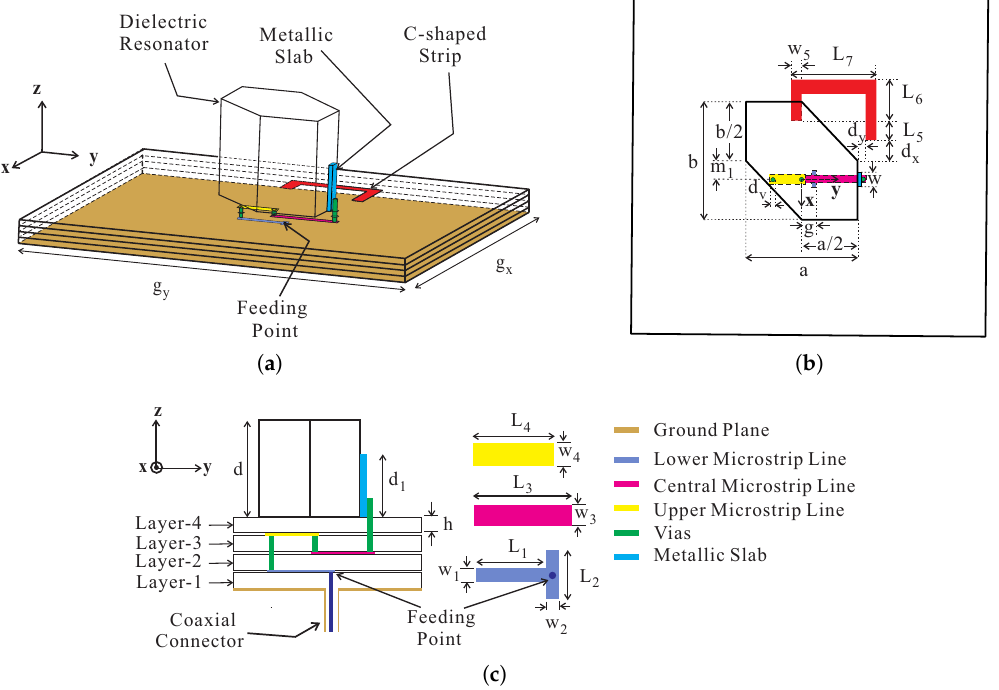
Figure 1. Geometry of the proposed dielectric resonator antenna (DRA): ( a ) 3-D view; ( b ) top view; and ( c ) sectional view. Table 1. Geometric parameters of the proposed